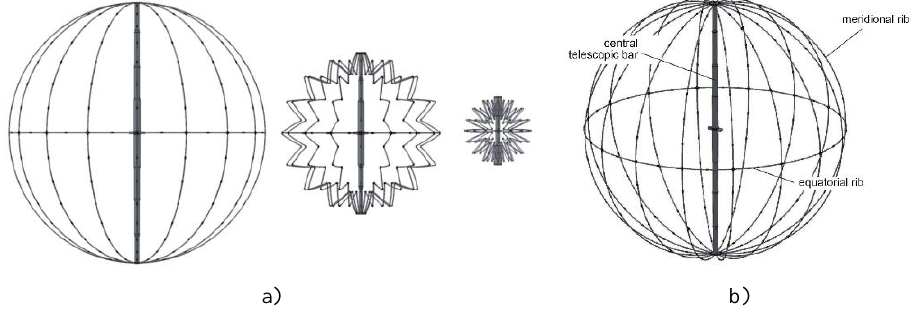
Fig. 25. Steps of CAS deployment and the CAS framework in the unfolded state: a) unfolded, intermediate and folded states of the reflector framework, b) load-bearing framework in the unfolded